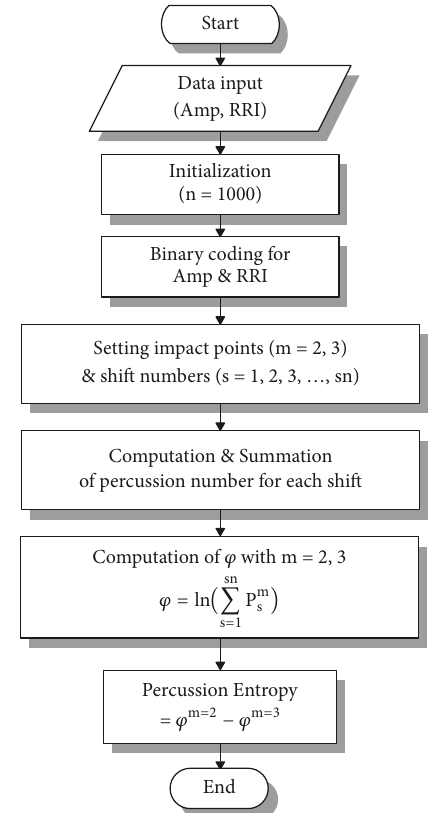
Figure 2: Flow chart of percussion entropy computation. Amp: amplitude; RRI: R-R